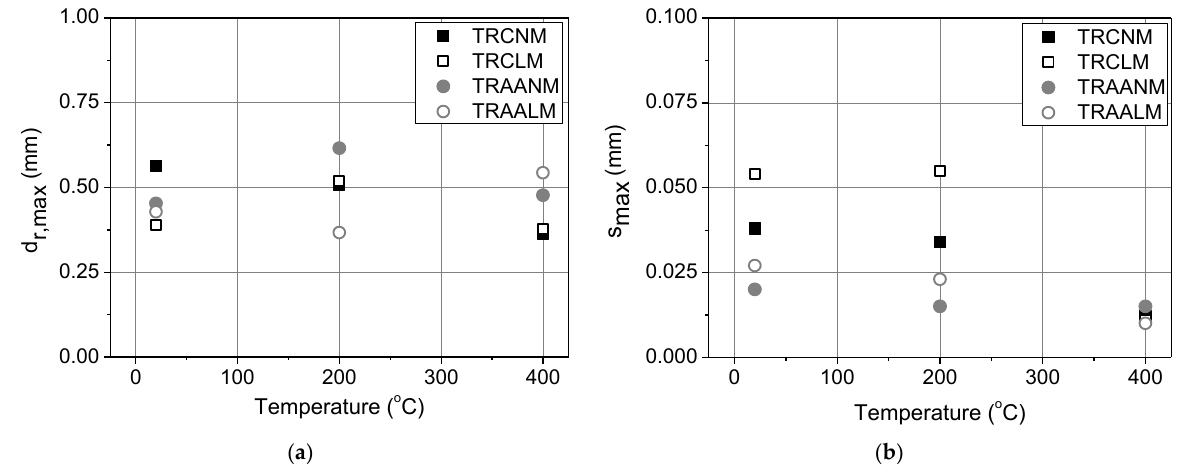
Figure 11. ( a ) The relative displacement ( d r , max ) and ( b ) slip ( s max ) corresponding to the maximum textile axial stress versus the exposure temperature.